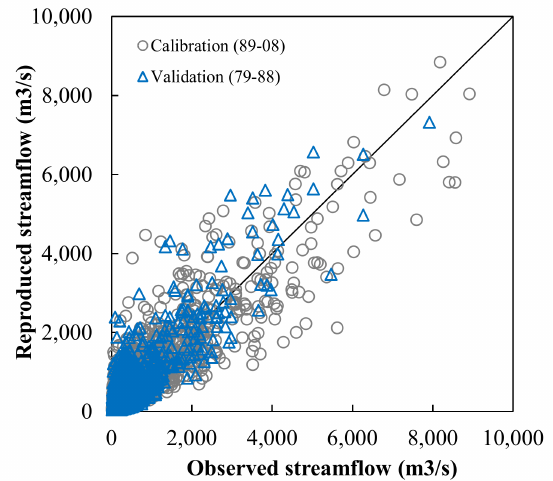
Figure 5. Scattered plot of daily observed and reproduced streamflow for the upper Thu Bon River basin at Nong Son in the calibration period (1989–2008) and validation period